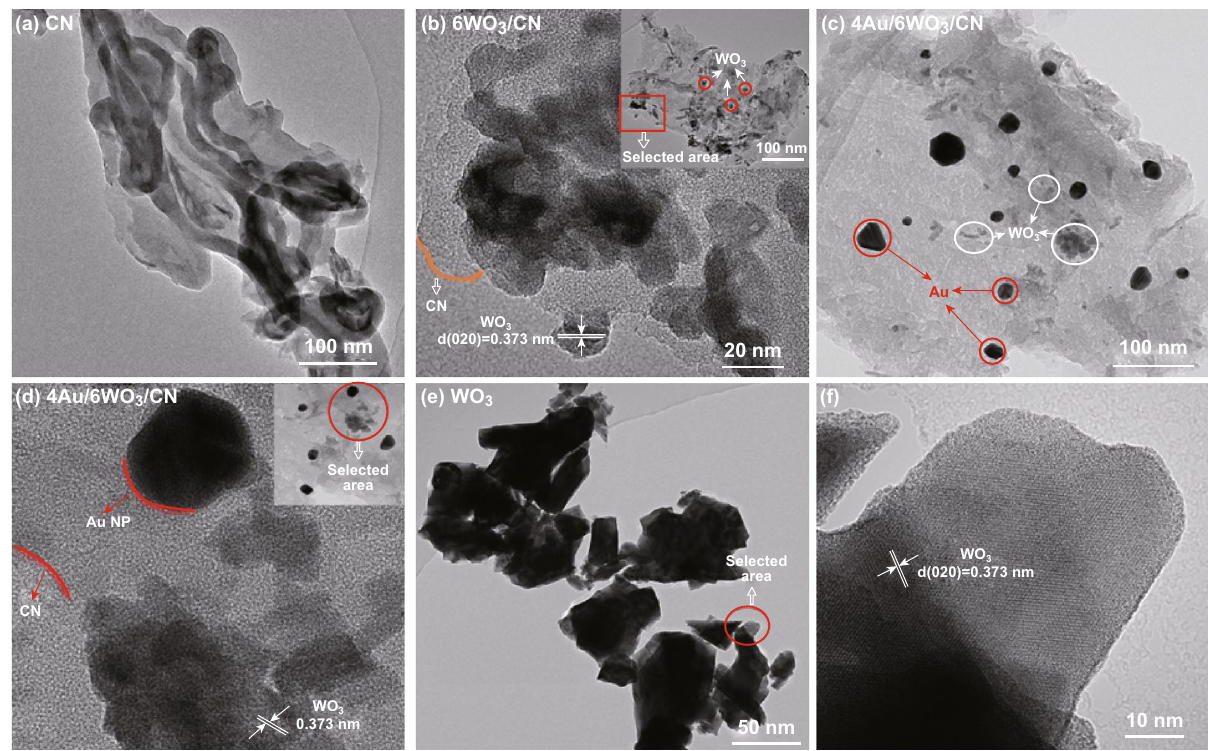
Fig. 2 a TEM image of CN, b HRTEM image with inset TEM image of 6WO 3 /CN composite. c TEM image of 4Au/6WO 3 /CN composite. d HRTEM image of 4Au/6WO 3 /CN composite with selected area TEM image as inset. e TEM image of WO 3 , and f HRTEM image of WO